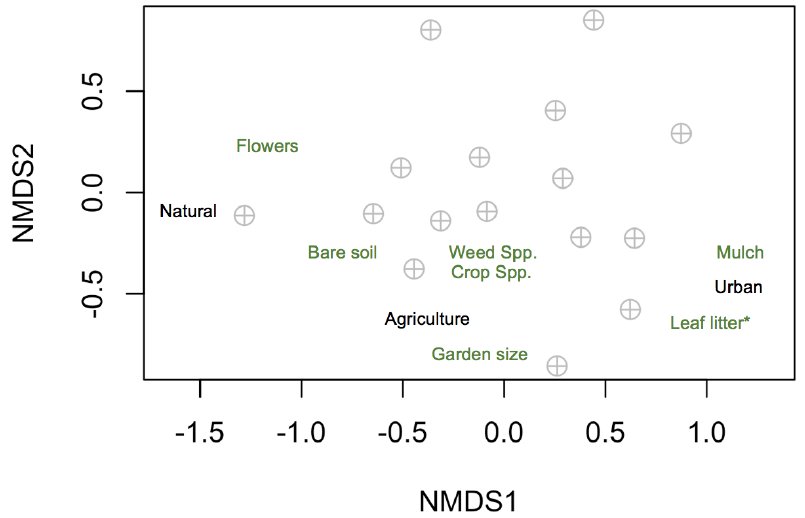
Figure 2. Non-metric multidimensional scaling plot showing carabid community composition in the sixteen gardens where beetles were collected in relation to local and landscape factors. The asterisk (*) indicates the one significant factor.